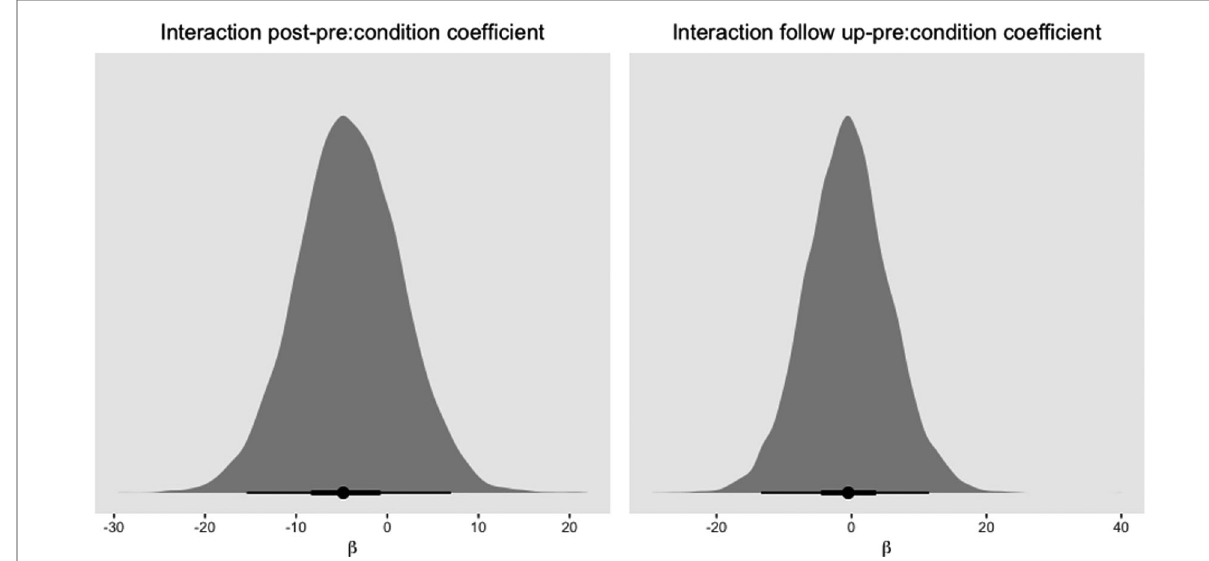
FIGURE 5 Histogram of mode of posterior distribution with 50% and 95% HDI for slopes of condition predicting PCL-5 scores. Note that a negative β coef fi cient indicates lower PTSD symptoms in the 3MR condition than in the TAU condition.